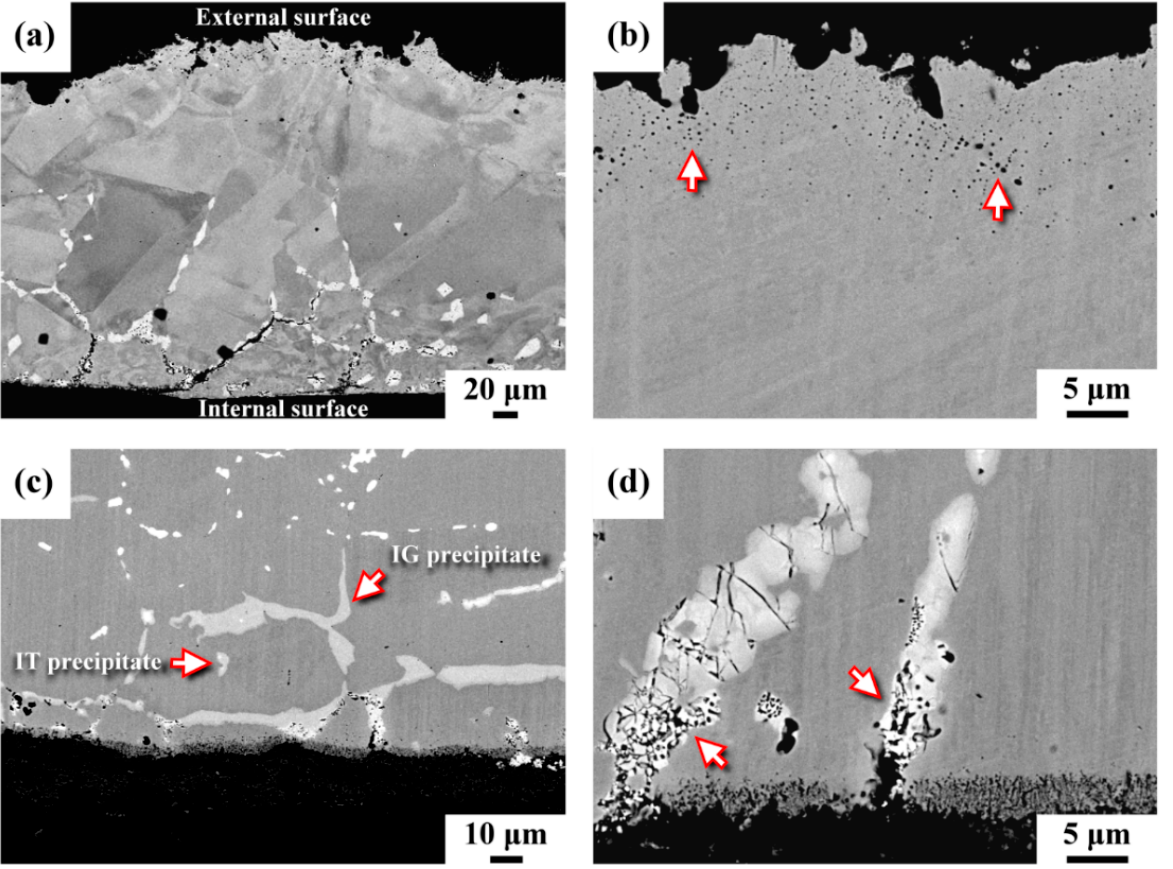
Figure 2. The microstructures of the samples cut from the ruptured pipe in the cross-sectional view: ( a ) the thinned sample beside the rupture, ( b ) the microstructure around the external surface, ( c ) the microstructure around the inner surface, ( d ) the etched inner surface and the cracking of coarse precipitates.